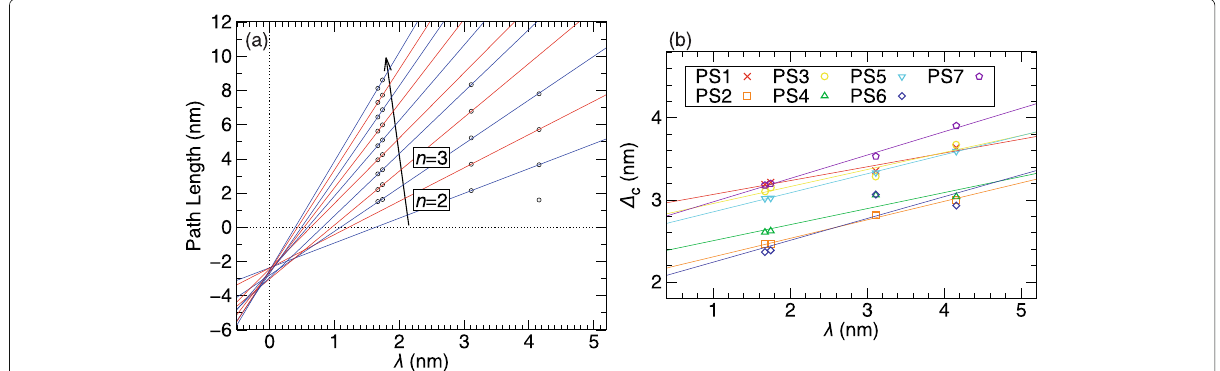
Fig. 15 Results of PS optimization in CP mode. a Path length at the optimal gaps as a function of λ for PS1 in CP mode. Calculated values from the optimal gaps are shown in circles. Red and blue solid lines are the results of linear fitting for n c ± 1 / 4. b (cid:10) c (λ) for the seven PSs calculated from the optimized p ( g ) and the determined n c in CP